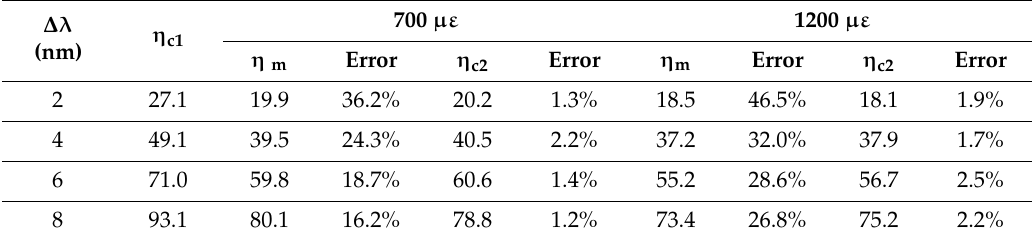
Table 1. Comparison of the measured and calculated mass losses